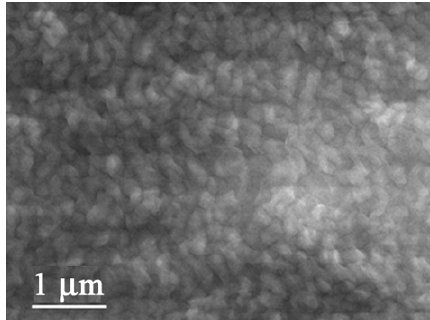
Figure 40. The chemical structure of ethylenedithio- and ethylenedioxy- tetrathiafulvalenoquinone-1,3-dithiolemethides ( EDT–TTFVO and EDO–TTFVO ).